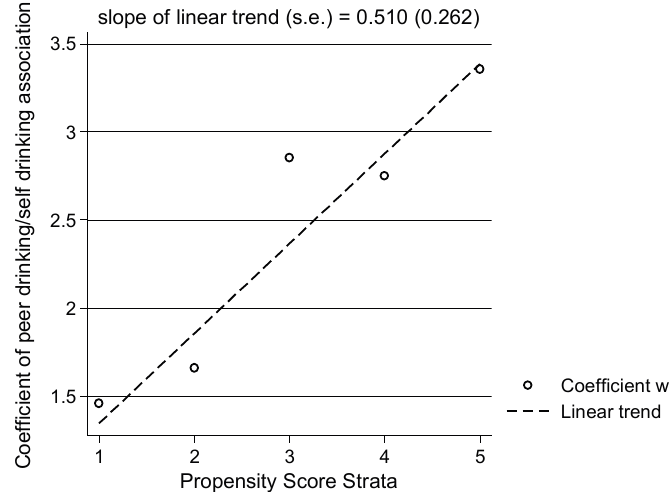
Figure 2. Graphical Representation of Heterogeneous Size of Peer-Drinking and Youth-Drinking Relationship ( N =